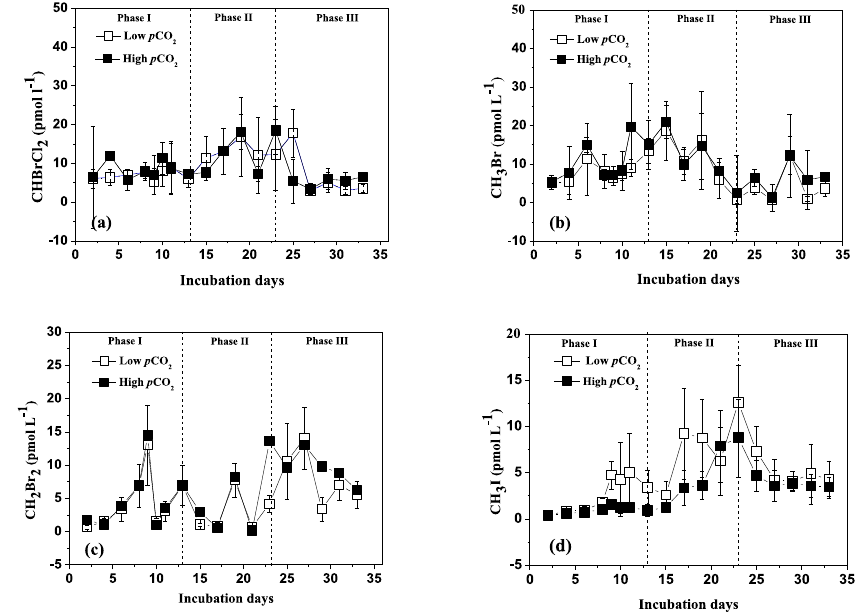
Figure 3. Temporal development in bromodichloromethane (CHBrCl 2 ), methyl bromide (CH 3 Br), dibromomethane (CH 2 Br 2 ), and iodomethane (CH 3 I) concentrations in the high p CO 2 (1000µatm, black squares) and low p CO 2 (400µatm, white squares) mesocosms. Data are mean ± SD, n = 3 (triplicate independent mesocosm